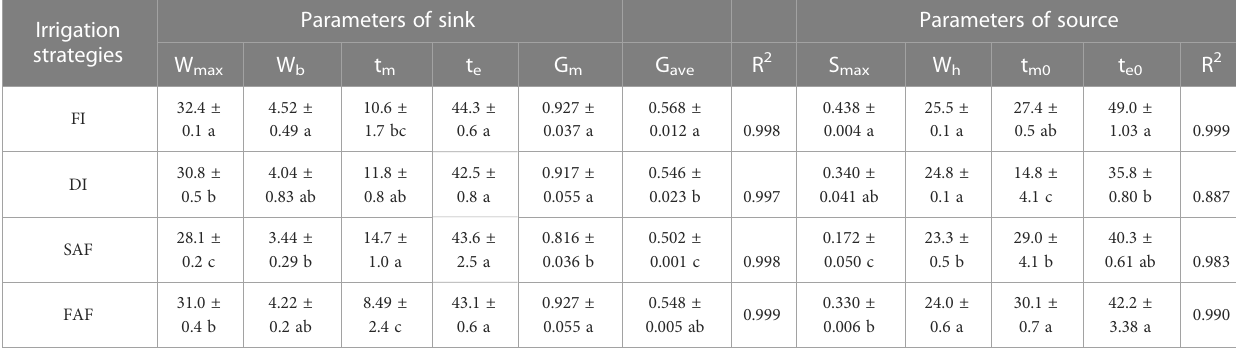
TABLE 3 Estimated parameters of rice sink activity and source activity in different irrigation strategy treatments.